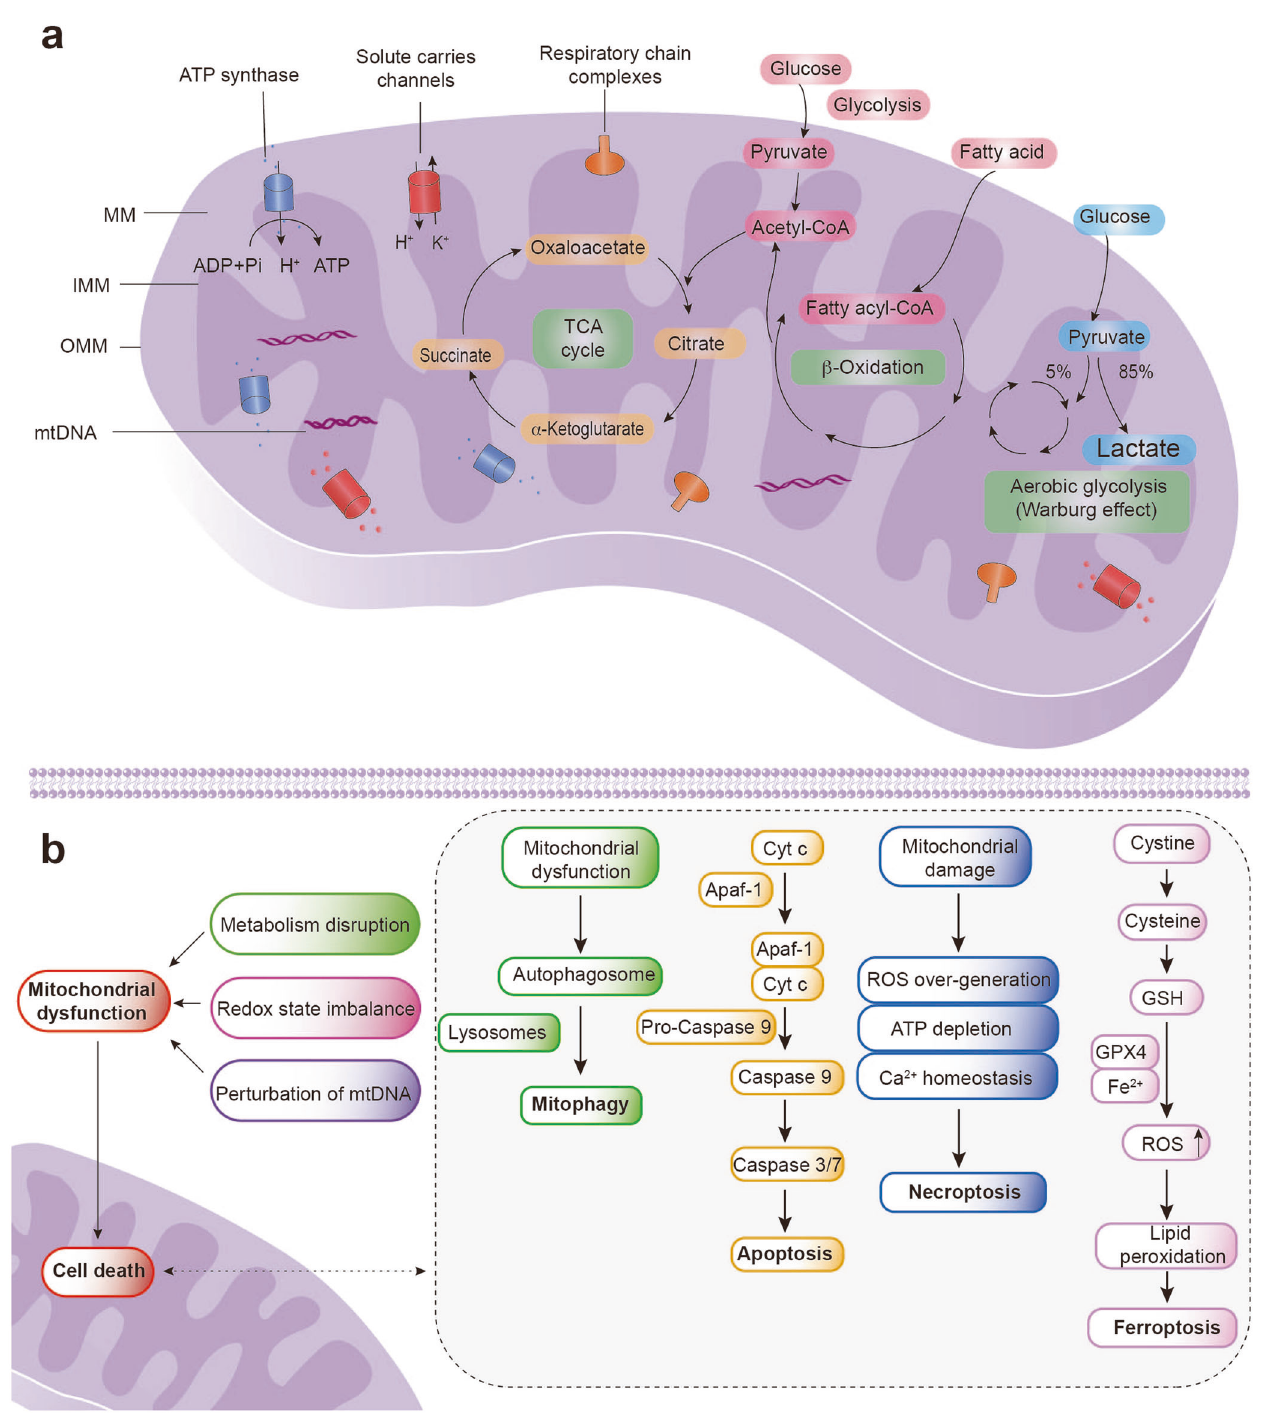
Fig. 4 Personalized therapeutic strategies toward mitochondria. a The structure and function of mitochondria are displayed, with emphasis on the TCA cycle and β -oxidation. In contrast, cancer cells rely on the “ Warburg effect ” to achieve energy supply. b Mitochondrial dysfunctions to trigger cell death include metabolism disruption, redox state imbalance, and perturbation of mtDNA. Once mitochondrial damage and mPTP opening occur, cell death may occur by mitophagy, apoptosis, necroptosis, or ferroptosis. IMM inner mitochondrial membrane, OMM outer mitochondrial membrane, MM mitochondrial matrix, PDK dehydrogenase kinases, GAPDH glyceraldehyde 3-phosphate dehydrogenase, ROS reactive oxygen species, GSH glutathione, Cyt C cytochrome C made in this area, studies of mechanisms and relationships Fang et al. 168 observed that mitochondria-targeted antioxidants between ferroptosis and mitochondria are still in their infancy; (Mito-TEMPO) enable the suppression of DOX-induced ferropto- much remains to be investigated. Unraveling the relationship sis-induced heart damage. These fi ndings support the effect of between mitochondria and cell death will inform the design of the mitochondria on ferroptosis. While great progress has been Signal Transduction and Targeted Therapy (2022)